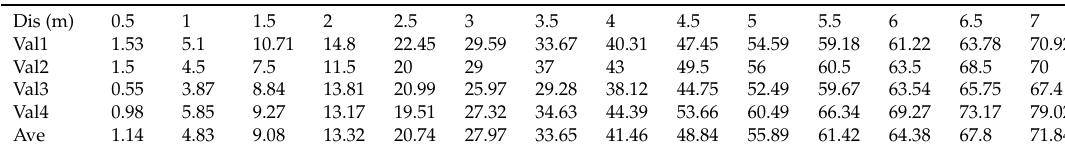
Figure 11. Results of the algorithm using a single size window: ( a ) Recall, ( b ) Precision. Table 4. Recall while using multi-scale 3D windows.